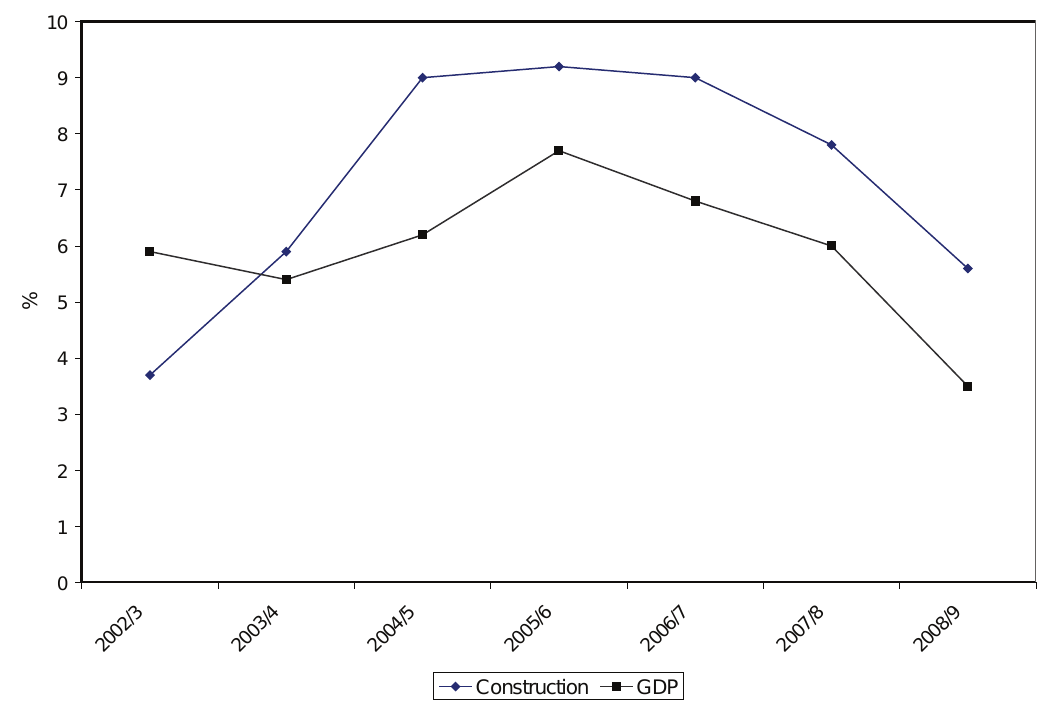
Figure 6. Growth rate of GdP and construction at constant (2002) prices source: department of census and statistics, sri Lanka